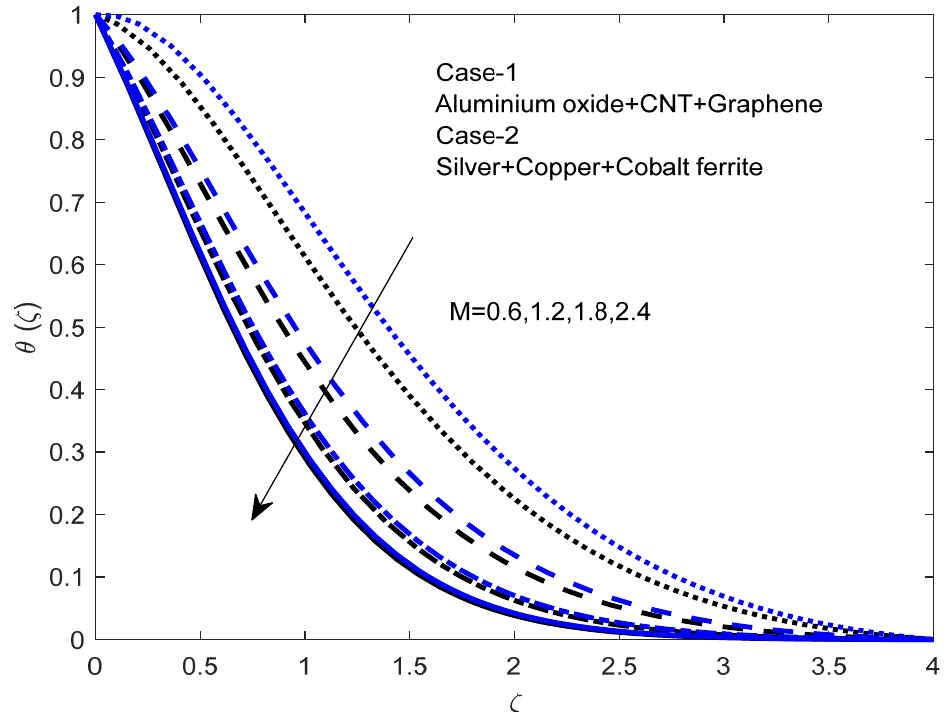
Figure 4. The effect of M on the temperature profile.